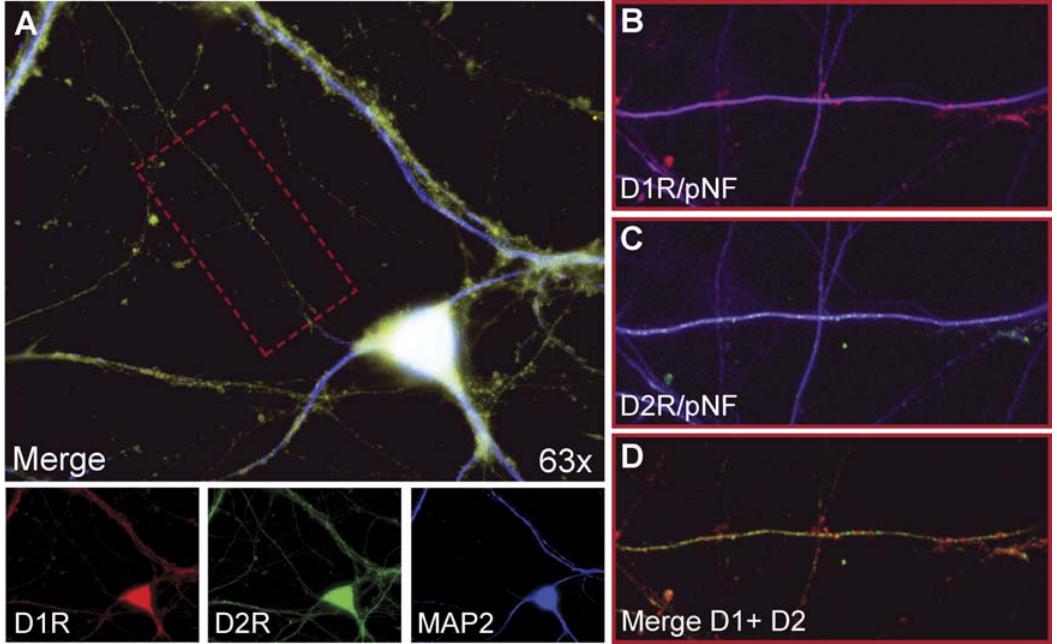
Figure 2. Both dopamine receptor subtypes are expressed in the same hippocampal neurons (A–D). A. A typical pyramidal neuron that was used in mitochondrial motility studies shows expression of both D1 and D2 receptors (A, top panel). D1 receptors (D1R) are shown in red (bottom, left panel); D2 receptors (D2R) are shown in green (bottom, middle panel); MAP2 expression (soma and dendrites) is shown in blue (bottom, right panel). The merged image (A) indicates colocalization (yellow). B–D. Detail of expression of D1R (B) and D2R (C) in axons (enlargement of rectangular region indicated by red dashed border in A); merged image of D1R and D2R labeling is shown in D (labeling of axon has been removed for clarity). Axons in B and C are immunolabeled with phospho-neurofilament (pNF) antibody (purple).